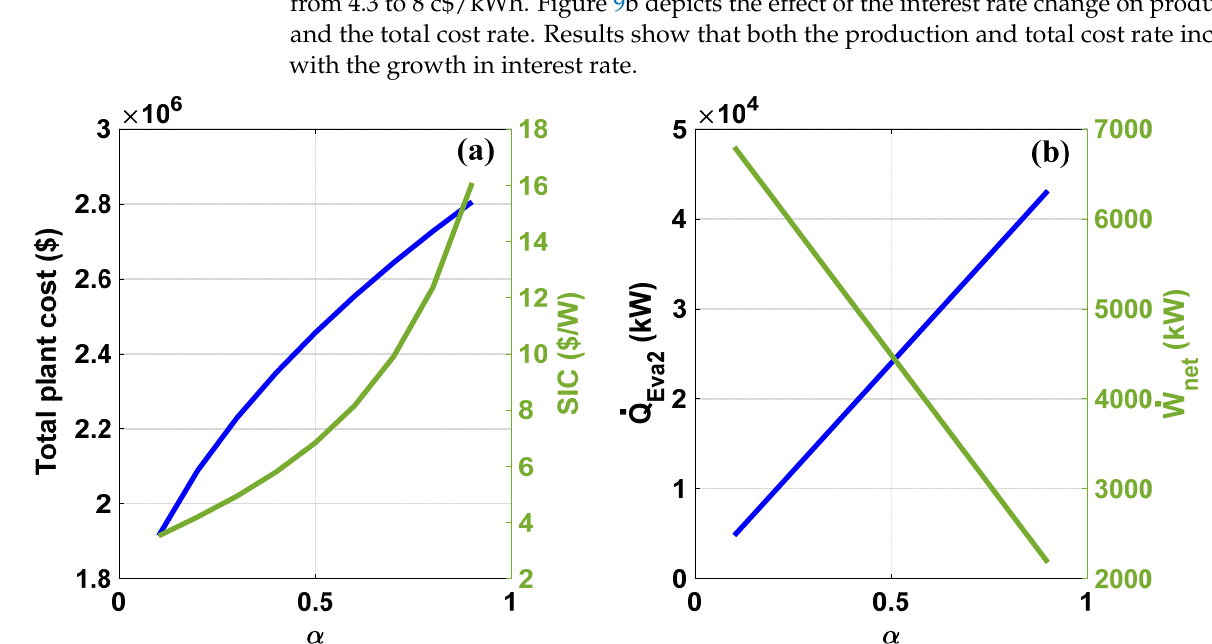
Figure 8. ( a ) The total plant cost and specific investment cost variations with cooling to power flow ratio. ( b ) The evaporator 2 and net power variations with cooling to power flow ratio.